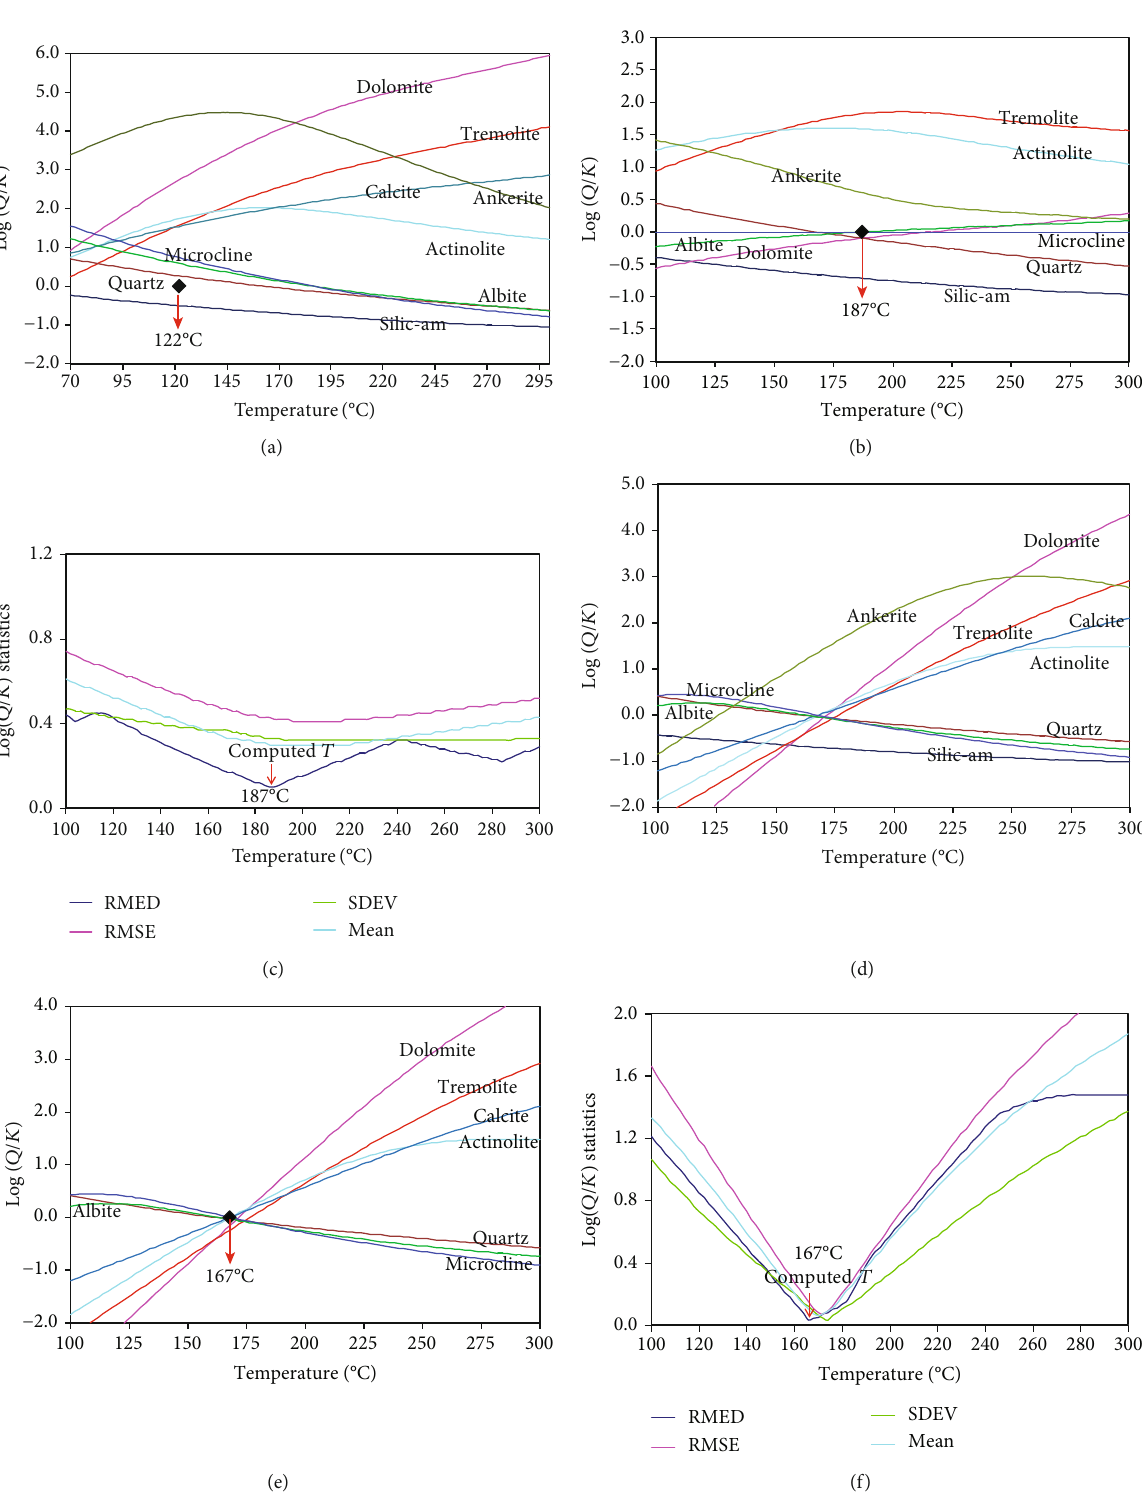
Figure 4: Simulation results for water sample G01 in the Julong thermal spring obtained by the integrated multicomponent geothermometry method. (a) Mineral saturation index variation with temperature for the base case. (b) Mineral saturation index variation with temperature